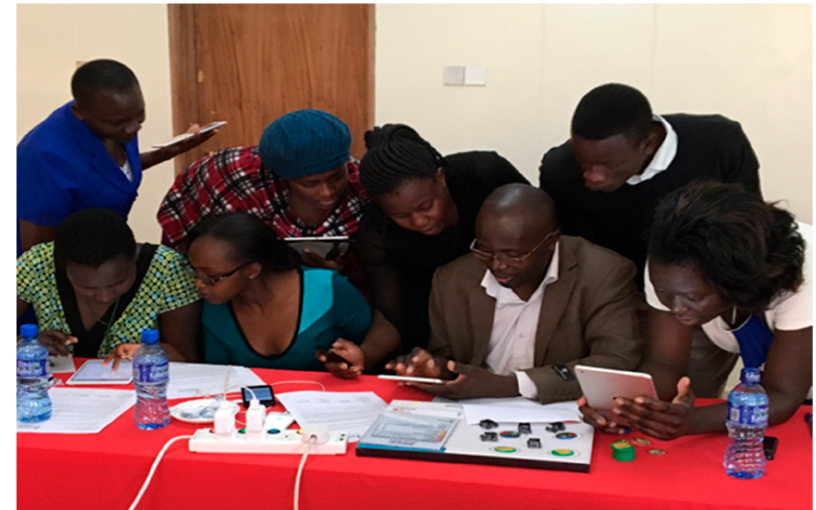
Figure 2. Nzoia WeShareIt game session 6 in Trans-Nzoia county government. One key observation from this game session was the participants barely sat at their tables, they moved around to find solutions to their common challenges and did not make decisions before discussing with other members of the water negotiation